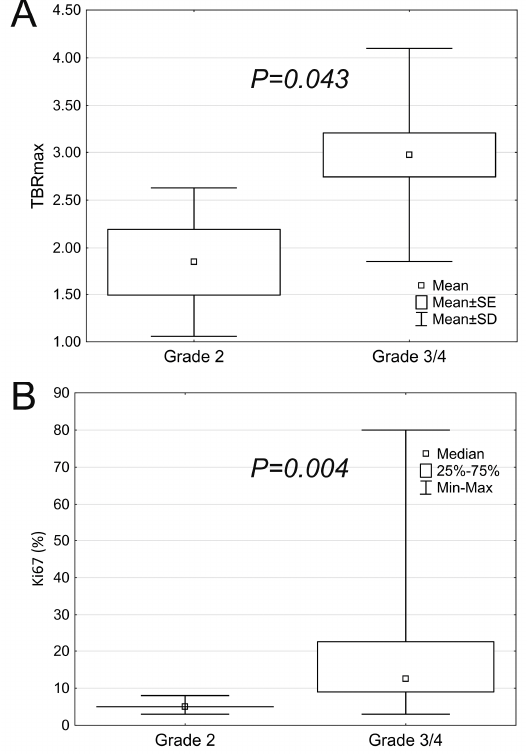
Figure 4. TBRmax ( A ) and Ki-67 ( B ) in low- and high-grade tumors. Correlation analysis revealed a mild association between SUVmax and Ki-67, how- ever, the latter proved to be independent of TBRmax (Figure 5).